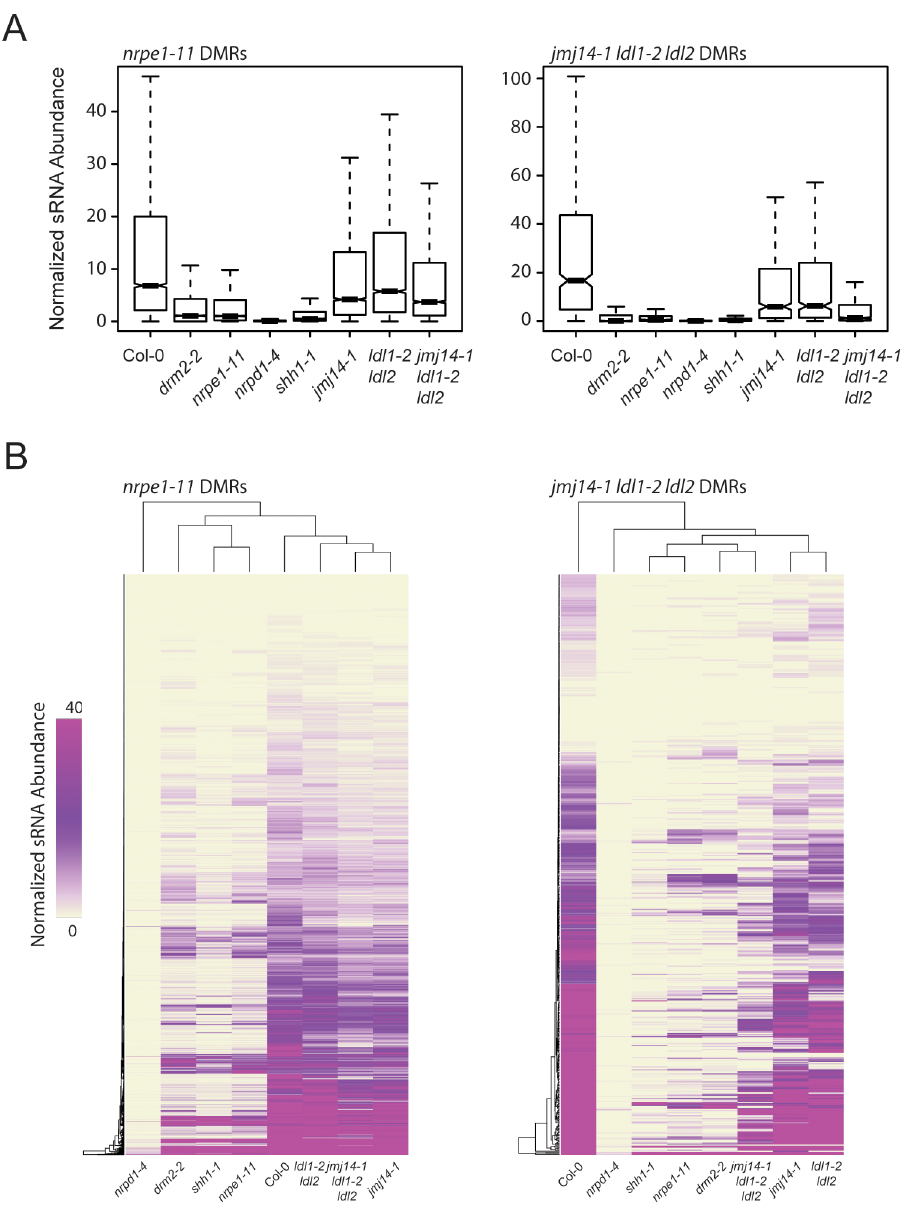
Figure 5. jmj14-1ldl1-2ldl2 triple mutants are deficient for sRNA production at affected DMRs. (A) Boxplots of 24-nt siRNA abundance (RPKM) at nrpe1-11 and jmj14-1 ldl1-2 ldl2 DMRs for various mutants. (B) Distance clustered heat map of 24-nt siRNA abundance at DMRs for listed